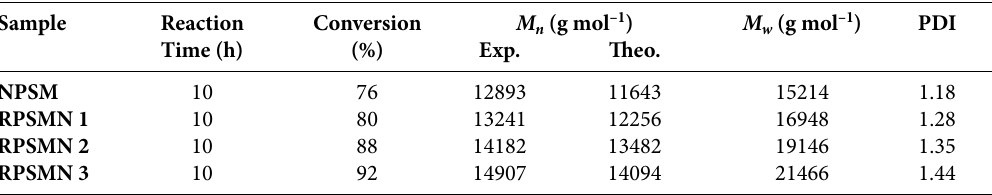
Table 2 : Molecular weights and PDI values of the extracted random poly (styrene-co-methyl methacrylate) chains result- ed from SEC traces